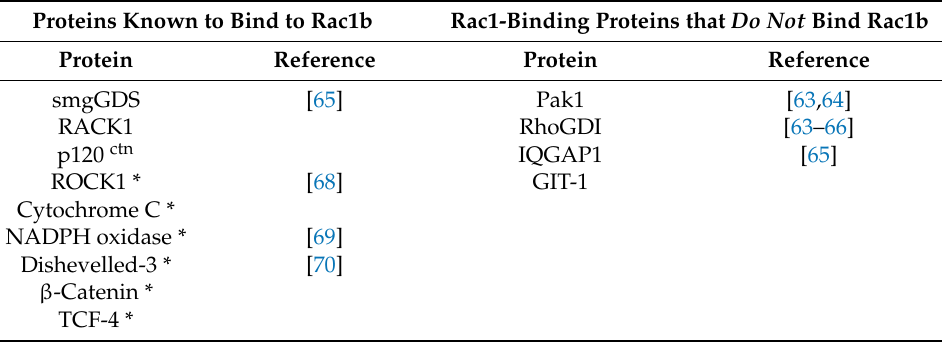
Table 1. Proteins that are known to bind or not to bind to Rac1b. Proteins Known to Bind to